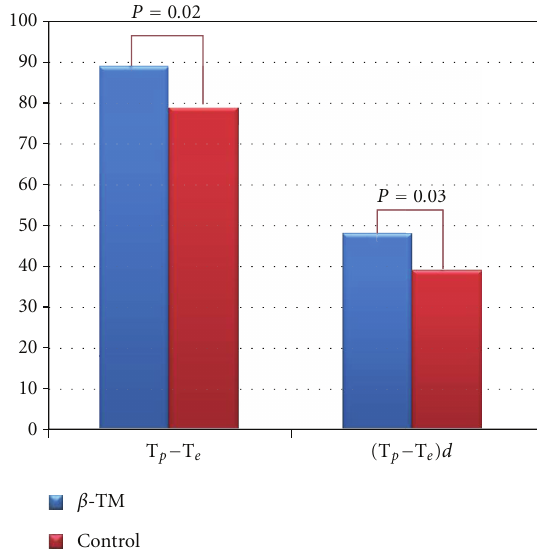
Figure 3: A comparison of T p − T e and ( T p − T e ) d in patients with β -TM and healthy controls.